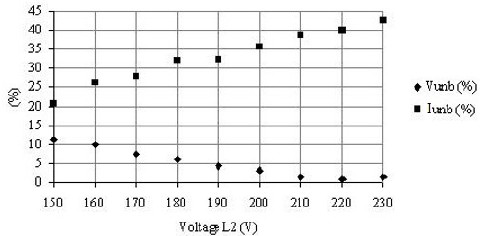
Figure 10. The unbalance factor for voltages V unb and currents I unb depending on the supply voltage of phase b (set 2).